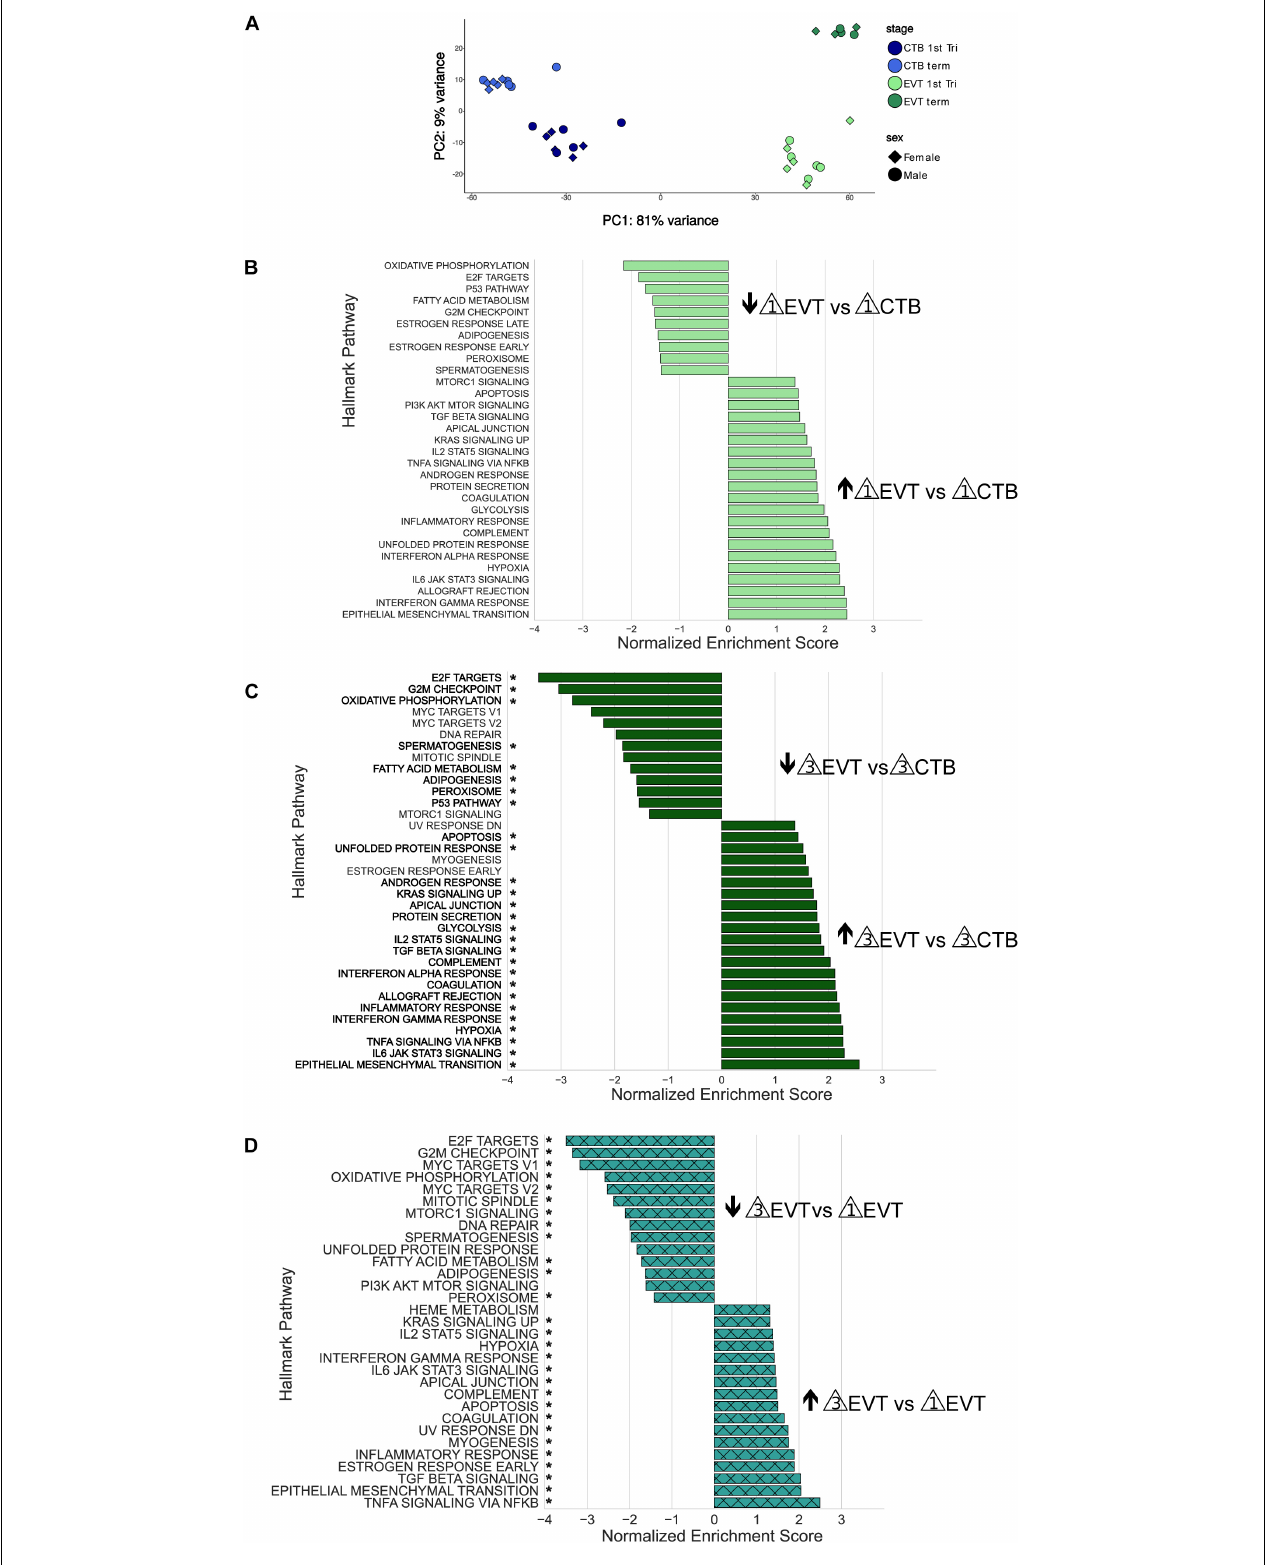
FIGURE 3 | Principal component analysis and Gene Set Enrichment Analysis (GSEA) of RNA-seq data. (A) Principal component analysis showing the first two components using all genes post-filtering of all 36 placenta samples (see Supplementary Table 1 ). Each sample group contained equal numbers of males and